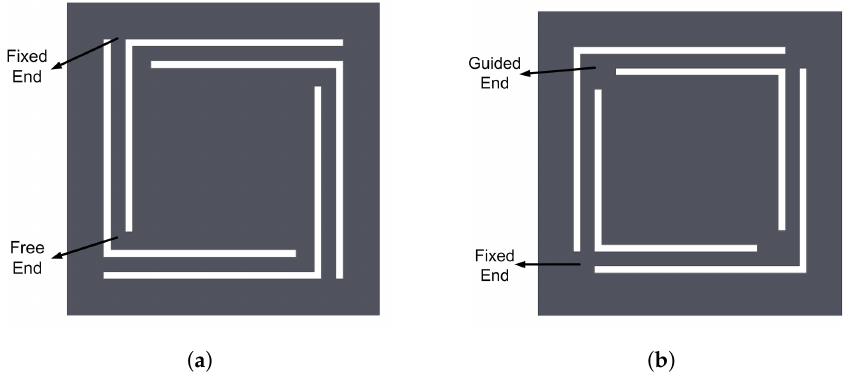
Figure 2. Different spring structures: ( a ) Linear spring. ( b ) Nonlinear spring.